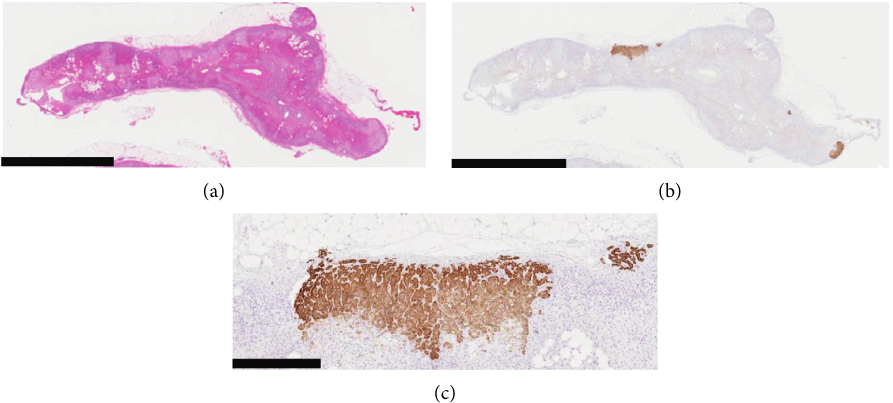
Figure 4: Histopathological findings of multiple micronodules and hyperplastic lesions in the left adrenal gland. (a) Hematoxylin and eosin staining. Multiple hyperplastic lesions in the left adrenal gland. Bar, 5mm. (b) CYP11B2 immunostaining. Multiple CYP11B2-positive micronodules were detected predominantly at the subcapsular area of the adrenal cortex and showed preserved zonation. Many CYP11B2- negative hyperplastic cells were detected in the zona glomerulosa; paradoxical hyperplasia of the zona glomerulosa was noted. Bar, 5mm. (c) CYP11B2 immunostaining. The magnified image of the CYP11B2-positive micronodules shown in (b). The CYP11B2 immunoreactivity waned from the subcapsular area to inward in the micronodules, in which zonation was preserved. Bar, 600 µ